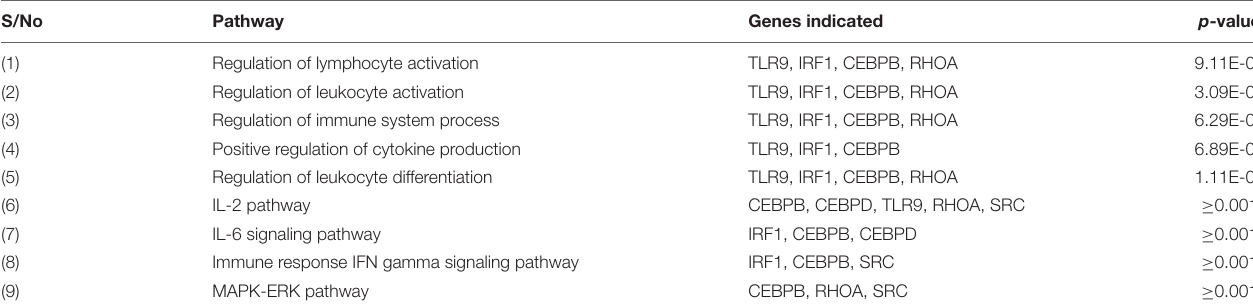
FIGURE 7 | The phylogenetic tree created using iTOL for the three miRNAs that returned homologous sequences from other species on Ensembl. miR-2325c is represented in blue, mir-22 in green, and miR-11975 in black. TABLE 4 | Immune-related and specific pathways in which significant genes are indicated from Gene Ontology and GeneAnalytics. S/No Pathway Genes